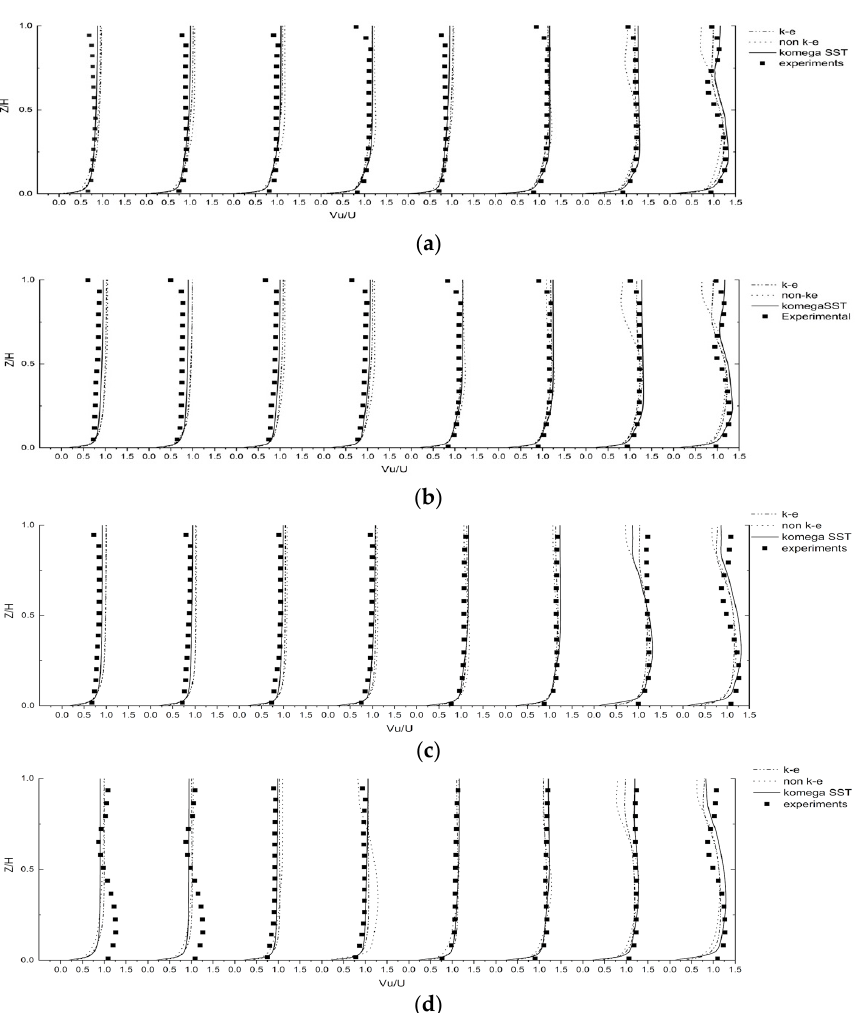
Figure 3. Distribution of streamwise component of velocity at 90 degrees under different jet condi- tions: ( a ) no jet, ( b ) S = 3.5 ( c ) S = 10 and ( d ) S = 16.5. From the left to the right is the outer bank to the inner